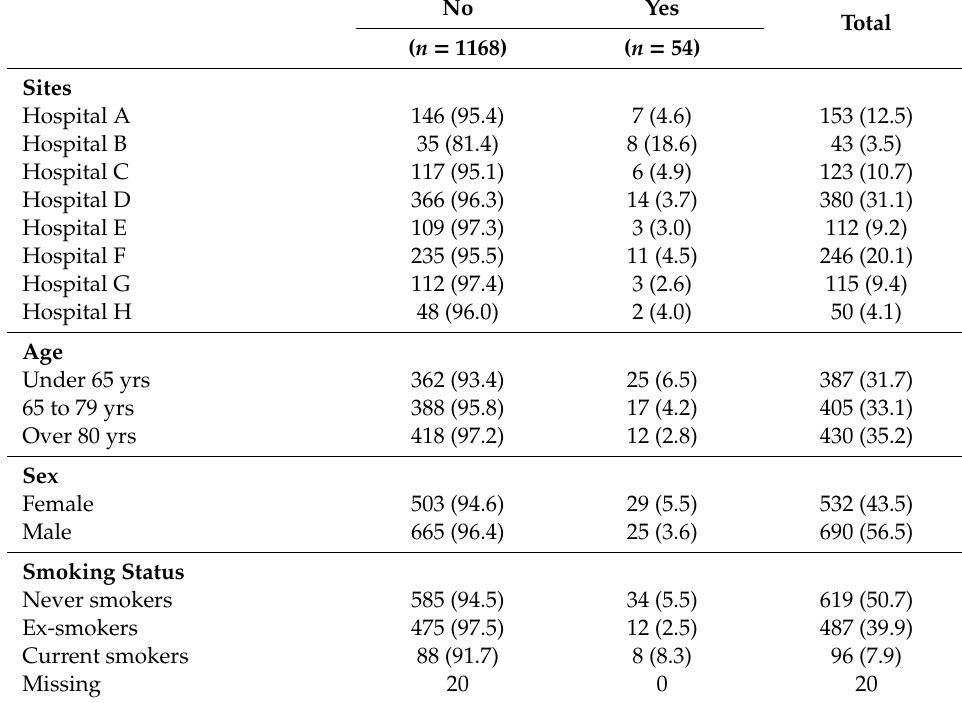
Table A1. Demographics and comorbidities by NSAID